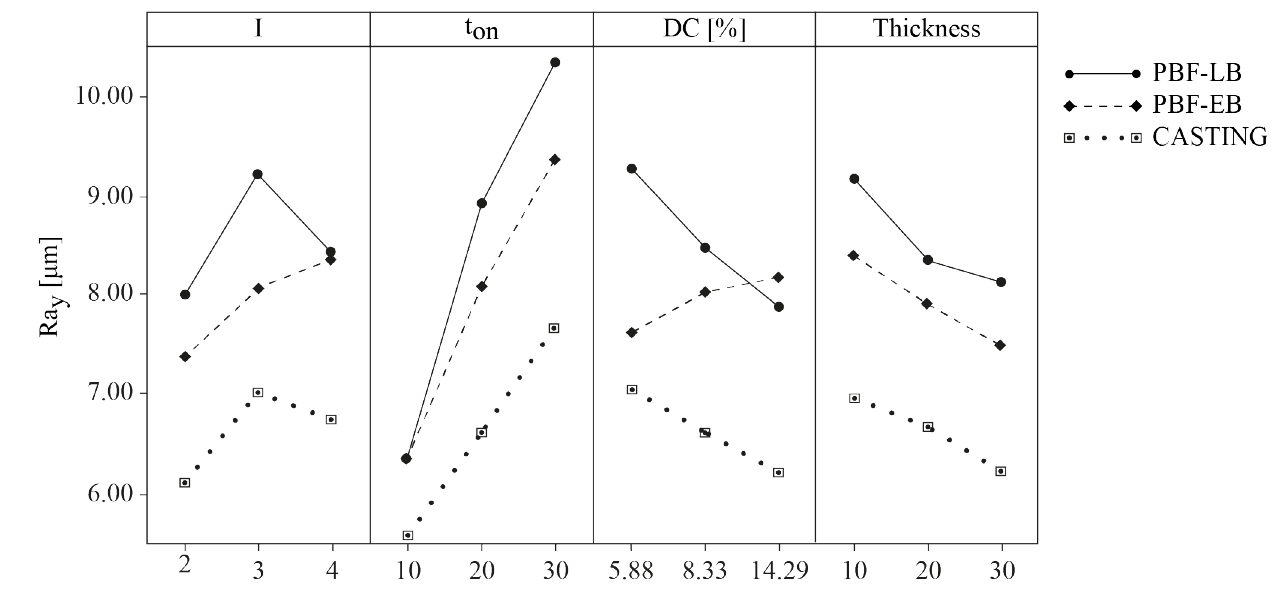
Figure A1. Main effects of process parameters Ra y of all processes. Similarly to Rax, the analysis of variance (ANOVA) was performed with a fixed con- fidence level equal to 95% to determine which process parameters and interactions signif- icantly affect Ra y variation for the two AM processes. Table A2 reports all the process parameters and interactions found significant for PBF-LB and PBF-EB. In both cases, a key role is played by ton and DC, which are the two most significant factors, while the signif- icance of the other parameters and interactions varies depending on the production tech- nology. Table A2. ANOVA table of significant process parameters and interactions for Ra y for PBF-LB and PBF-EB.